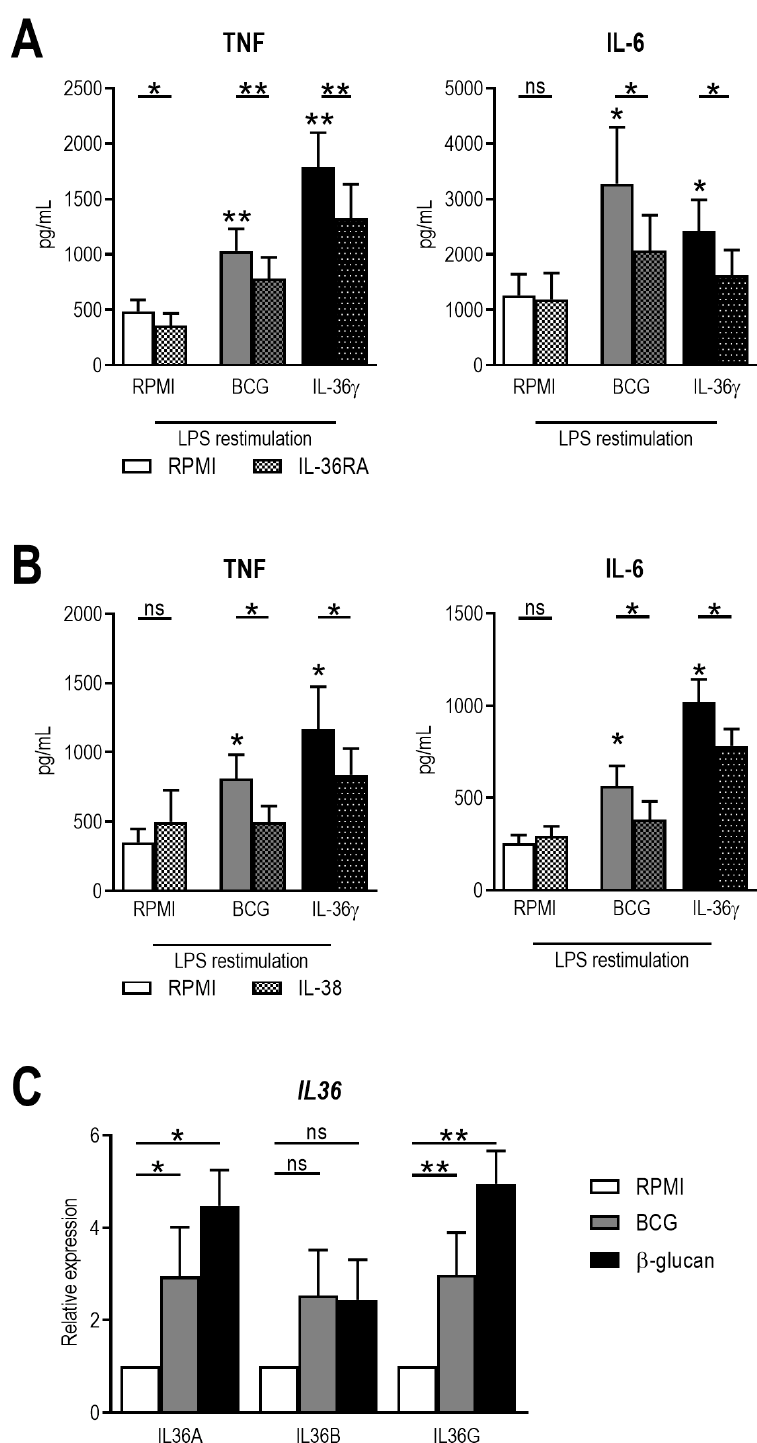
Figure 1. Trained immunity is inhibited by IL-36RA and IL-38. ( A , B ) Human monocytes were incubated for 24 h with 2 µ g/mL β -glucan or 2 µ g/mL of BCG with or without 400 ng/mL IL-36RA ( A ) or 90 ng/mL IL-38 ( B ). After five days of rest in medium, cells were restimulated with 10 ng/mL LPS, and TNF and IL-6 were determined in supernatants. ( C ) Human monocytes were incubated for 4 h with b-glucan or BCG before mRNA isolation and determination of expression isoforms of IL-36. (Mean ± SEM, n = 6, Wilcoxon signed-rank test, ns = non-significant, * p < 0.05, ** p < 0.01.) Next, to validate the role of IL-36 in trained immunity, we used one of the isoforms (IL-36 γ ) to induce trained immunity. When human monocytes were exposed for 24 h to IL-36 γ and restimulated with LPS on day six, we observed an increased production of TNF and IL-6 compared to non-treated cells, showing that IL-36 γ is able to induce trained